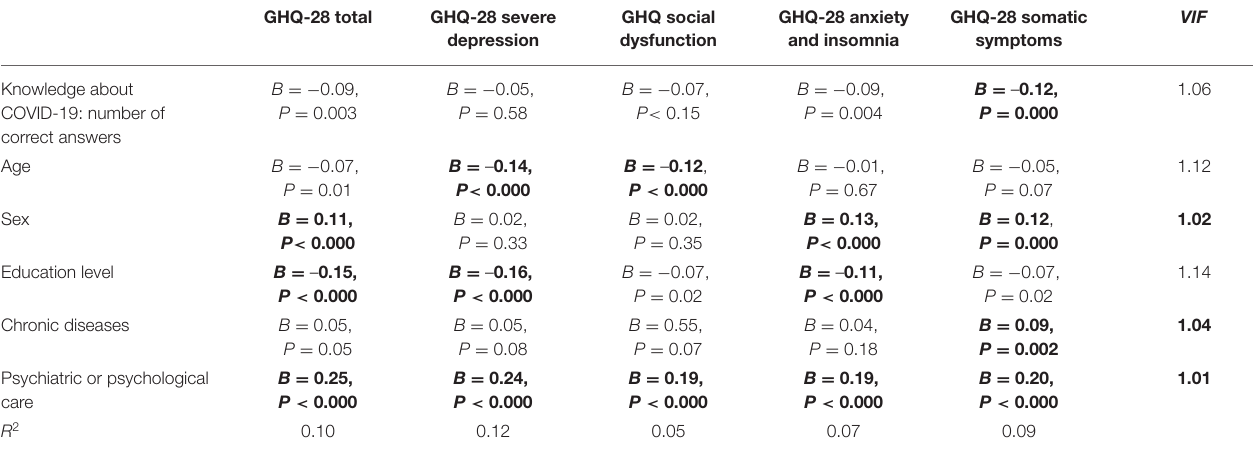
TABLE 3 | Factors related to the GHQ-28 score (results of linear regression analysis). GHQ-28